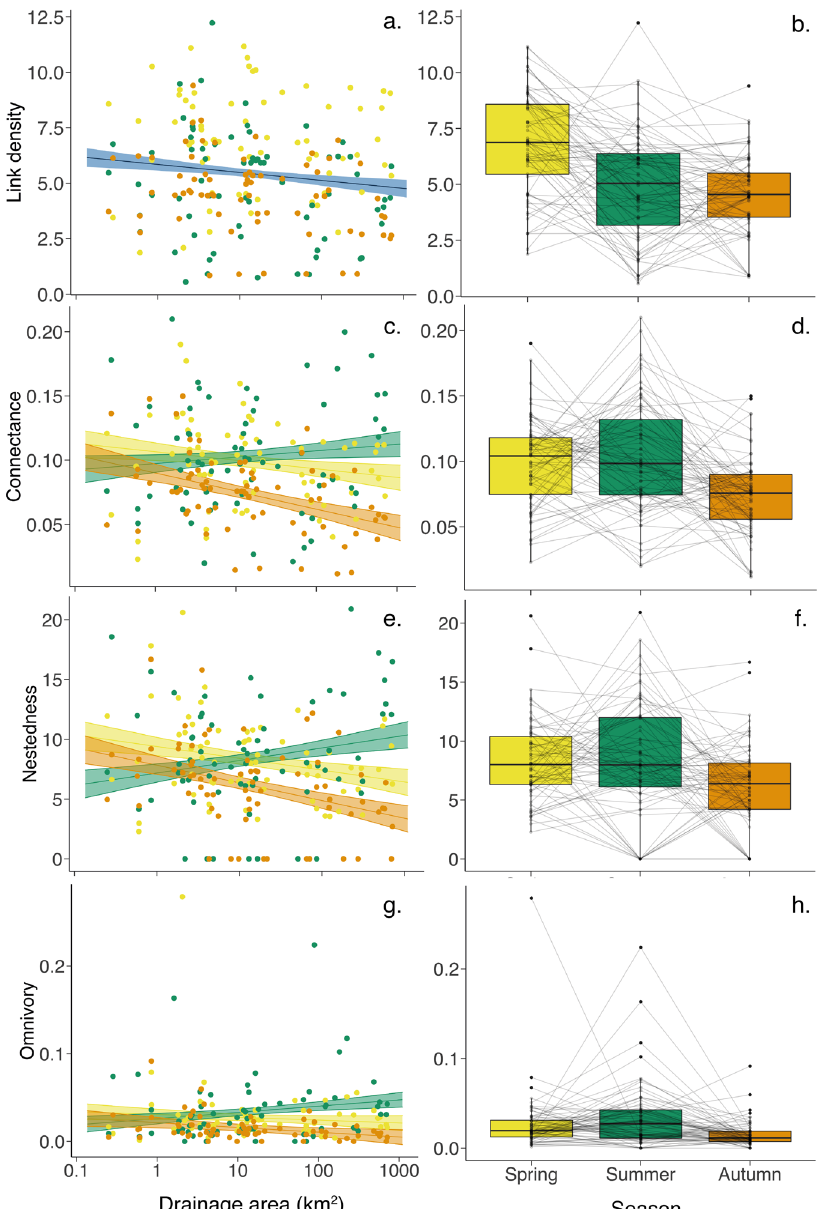
Fig. 4 Food-web structural characteristics. Plots show food-web structural characteristic: ( a , b ) Link Density, ( c , d ) Connectance, ( e , f ) Nestedness and ( g , h ) Omnivory. Lines indicate linear mixed-effects models with shaded area showing 95% con fi dence intervals as calculated using the model predictions and standard error. Plot a shows no signi fi cant interaction between drainage area and season, therefore the line indicates the model output of all the data as a function of drainage area which is marginally signi fi cant (blue). Plots c , e and g show the models with a signi fi cant interaction with the difference across each season (colour represents season). Plots b , d , f and h show the change in characteristic over season with samples sites linked by grey lines over the three sampling seasons. Colour represents season: yellow — Spring, green — Summer and orange —